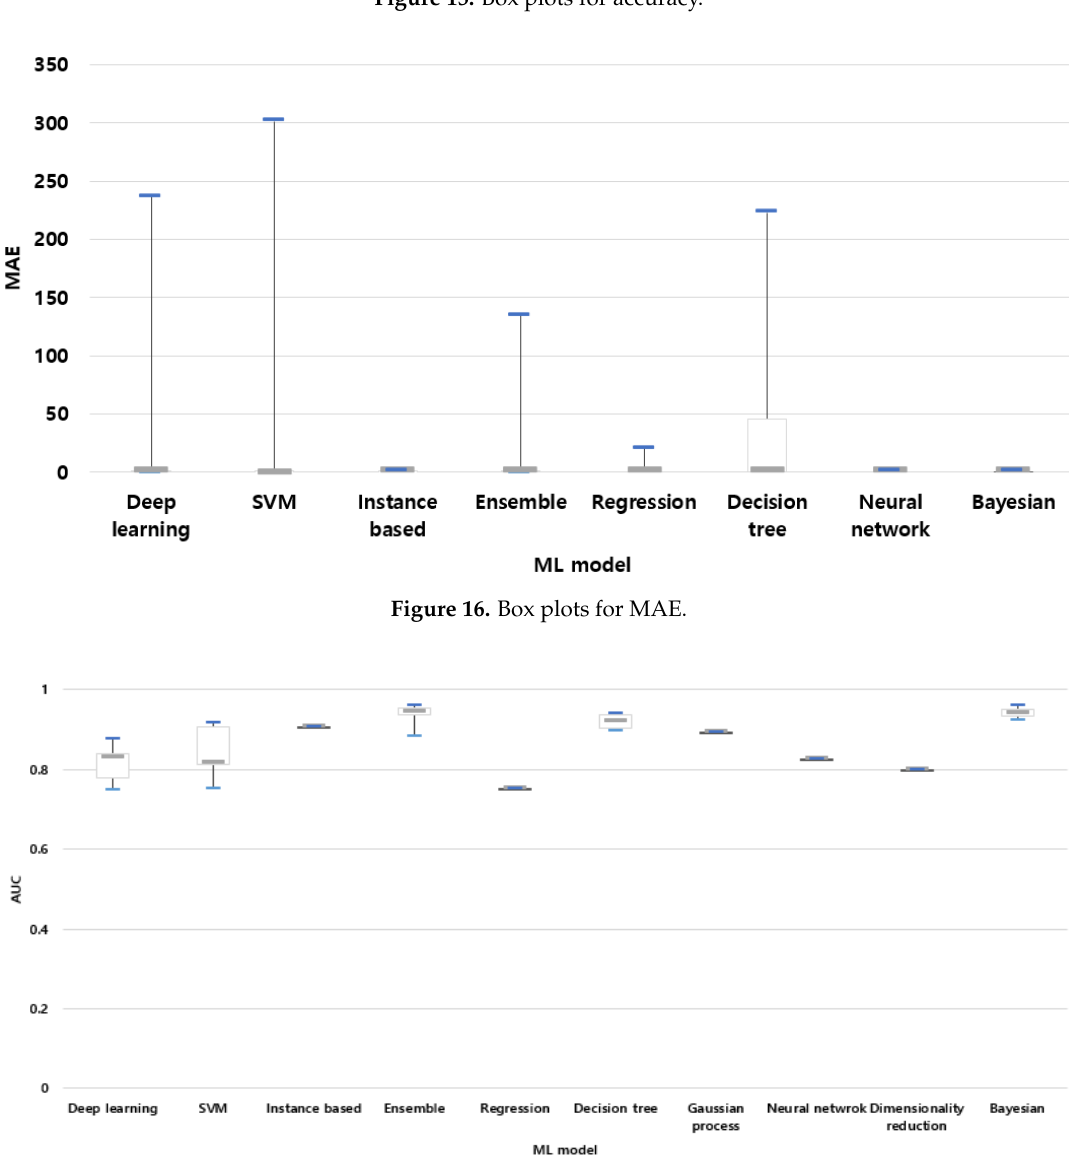
Figure 15. Box plots for accuracy.